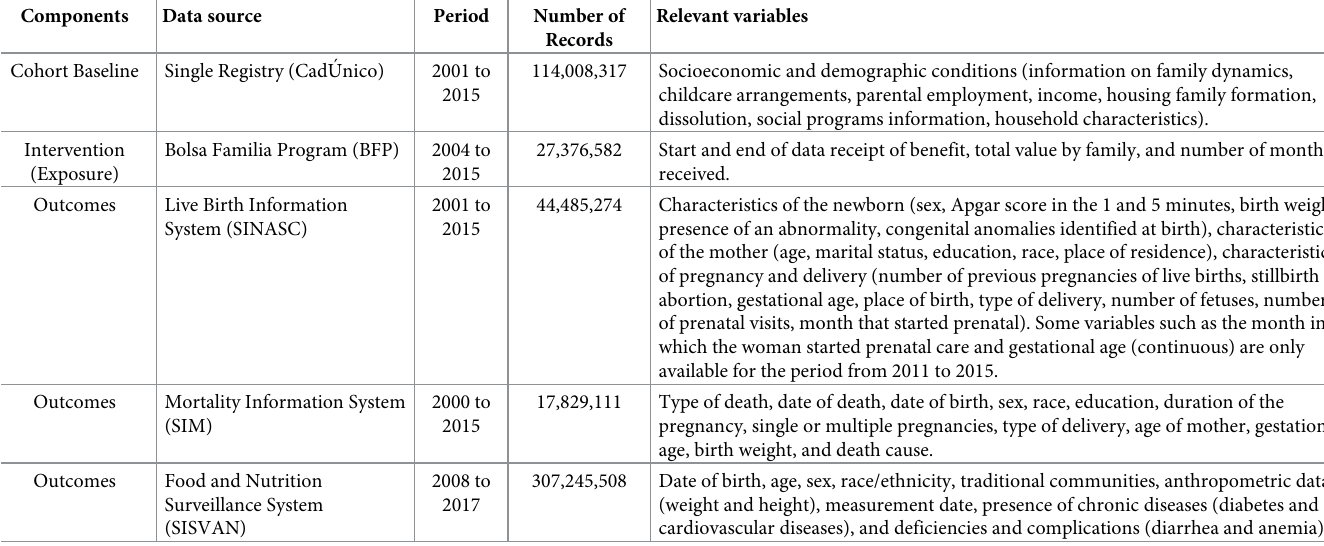
Table 1. Structure and main components of the 100 Million Brazilian Cohort, sources of data, and relevant variables.